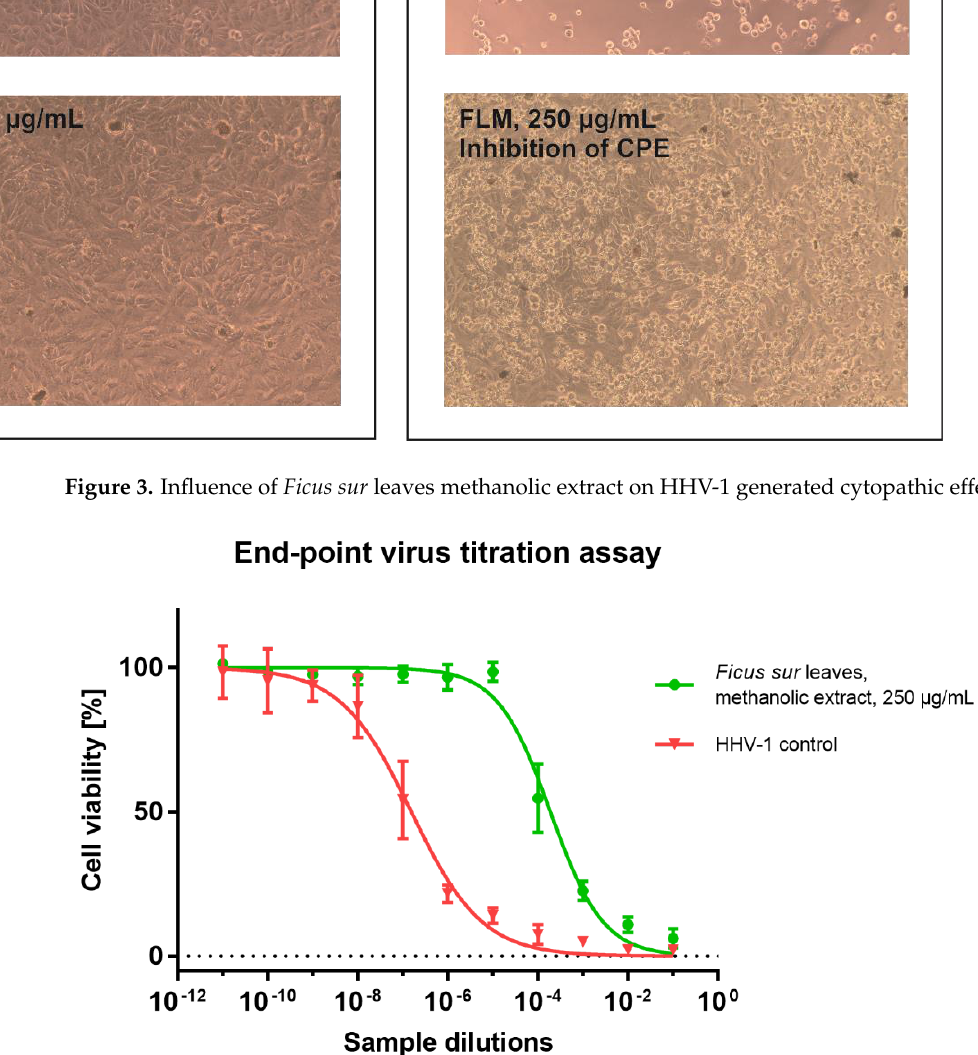
Figure 4. Titration assay of HHV-1 in the sample treated with Ficus sur leaves methanolic extract .